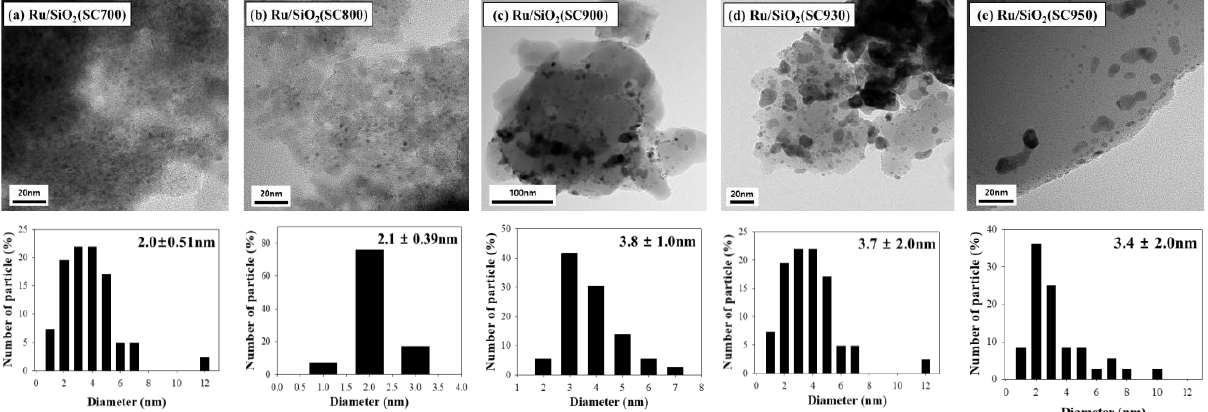
Figure 1. TEM images and particle size distributions of Ru metal for ( a ) Ru/SiO 2 (C100), ( b ) Ru/SiO 2 (C300), ( c ) Ru/SiO 2 (C500), and ( d ) Ru/SiO 2 (C700). All catalysts were calcined in air at differ- ent temperatures and subsequently reduced in H 2 at 350 °C.